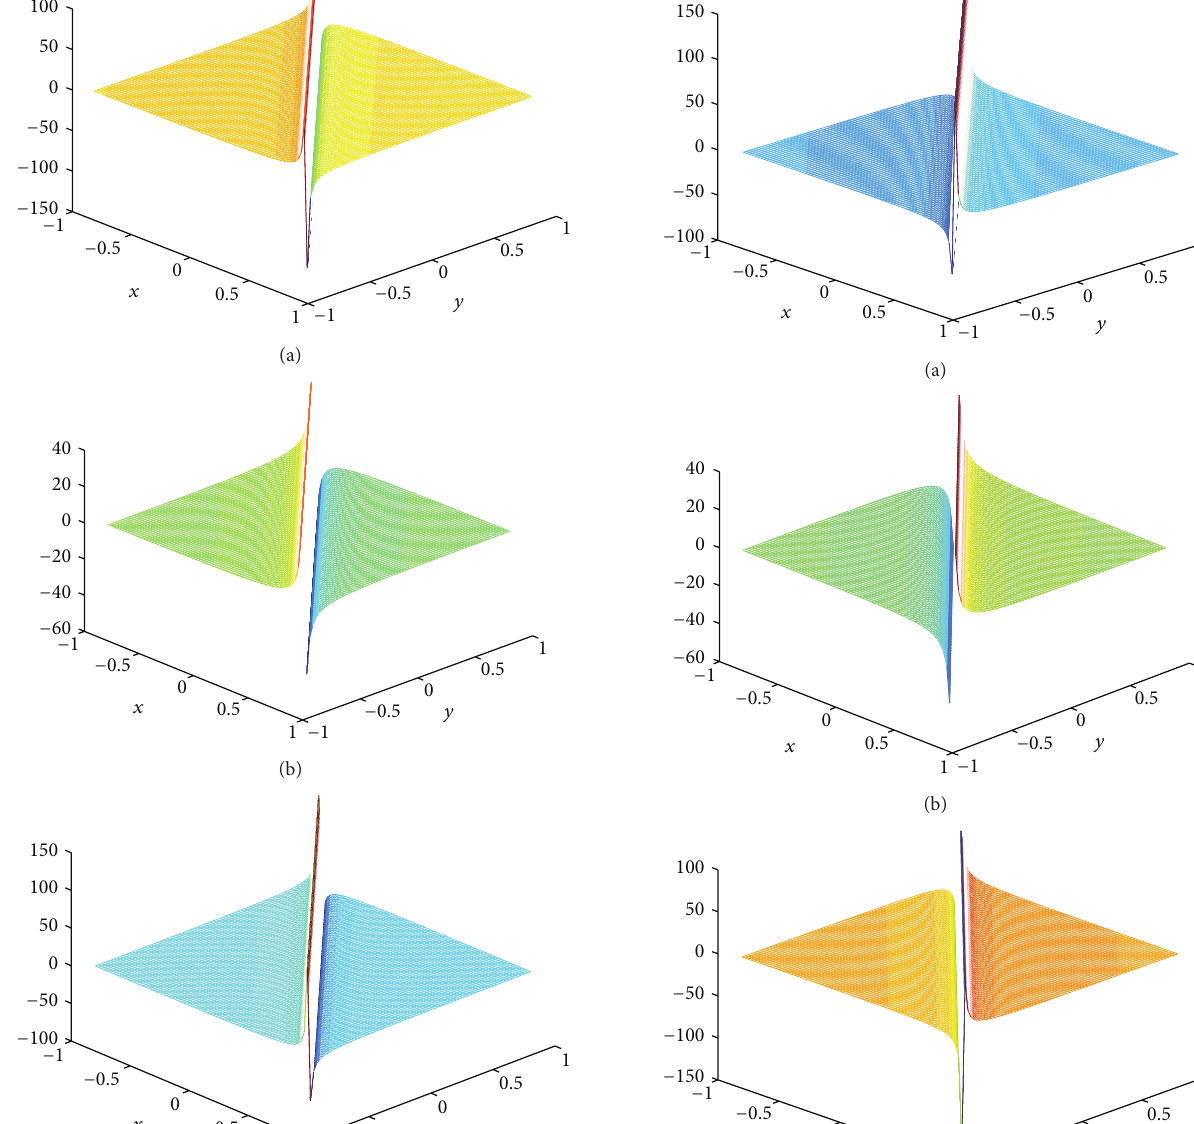
solutions 𝑢 𝑟,2 (𝑧) and simply periodic solutions u